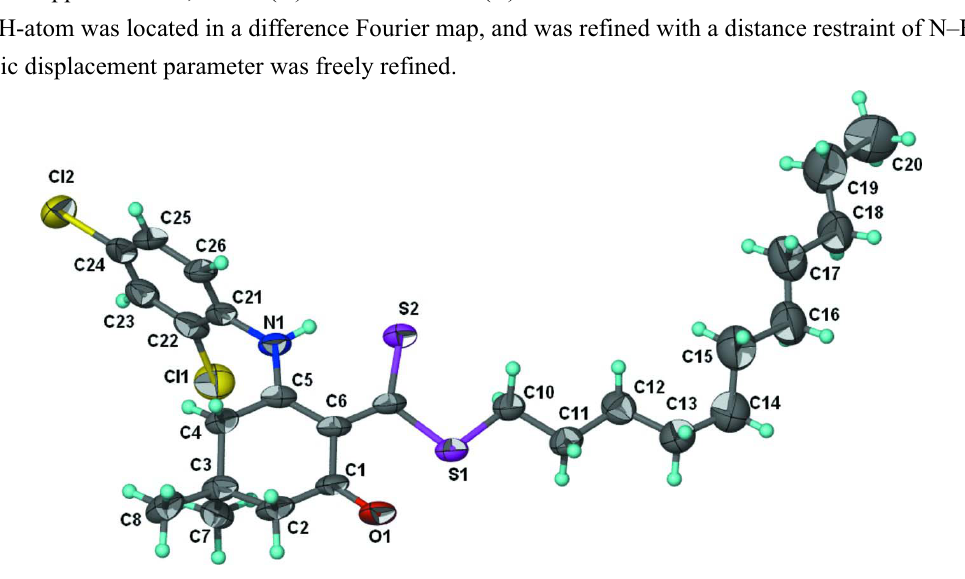
H Cl NOS at the 70% probability level; hydrogen 26 37 2 2